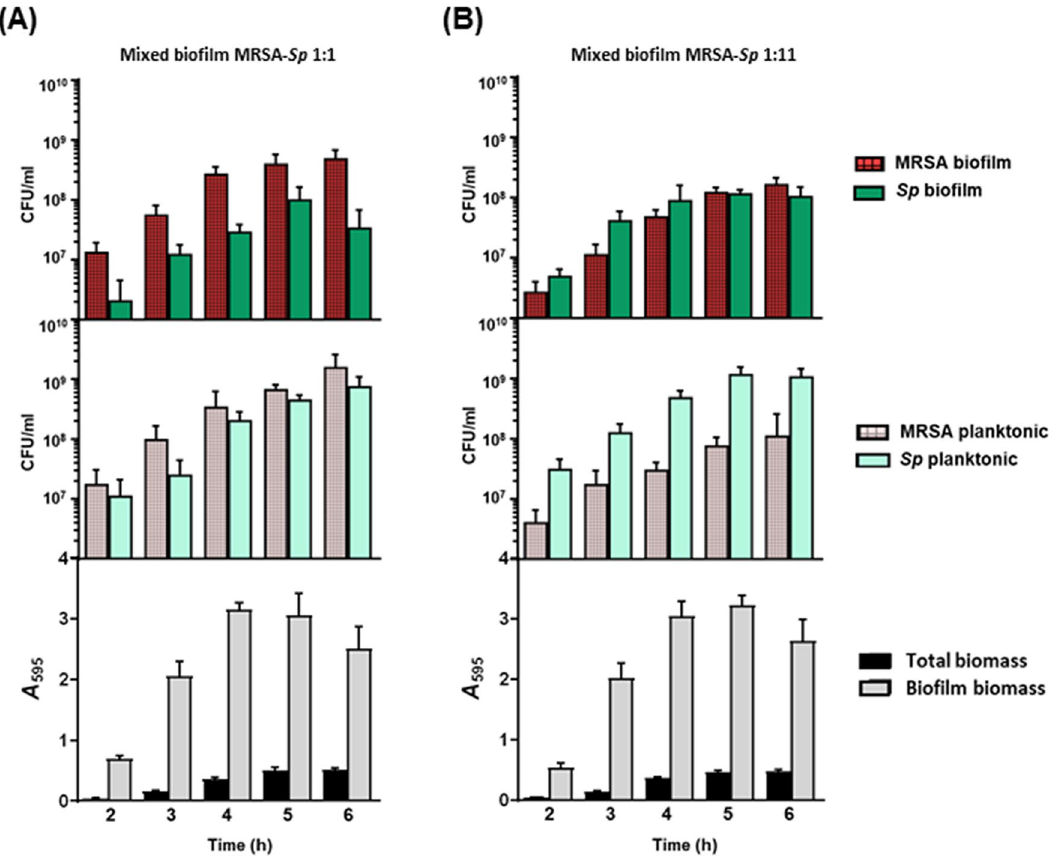
Figure 3. Time course of MRSA- Sp mixed biofilm formation using two proportions. ( A ) Mixed biofilm MRSA- Sp 1:1. ( B ) Mixed biofilm MRSA- Sp 1:11. In the top panel is represented MRSA (patterned red) and S. pneumoniae (green) viable cells within the biofilm. In the middle panel is represented MSSA viable cells (light patterned red) and S. pneumoniae (light green) viable cells in the planktonic culture. In the bottom panel is represented the total biomass (black bars) and biofilm biomass (grey bars) determined by CV staining. The data represent the average of six experiments. Standard deviation bars are